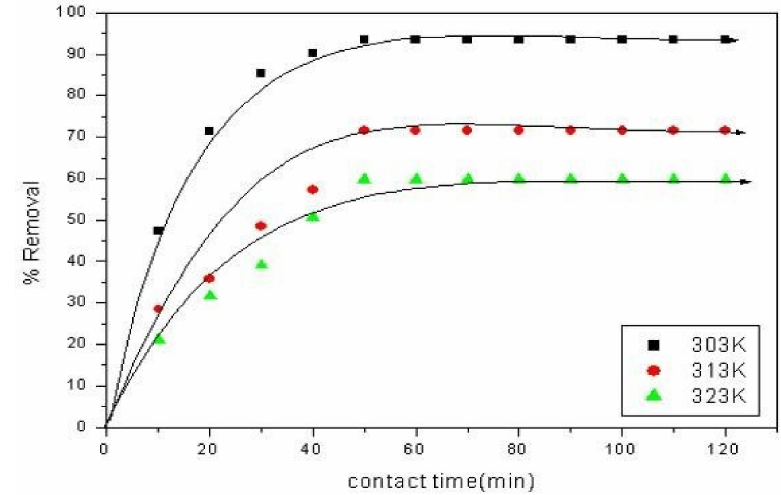
Figure 8. Modified wheat husk [13].